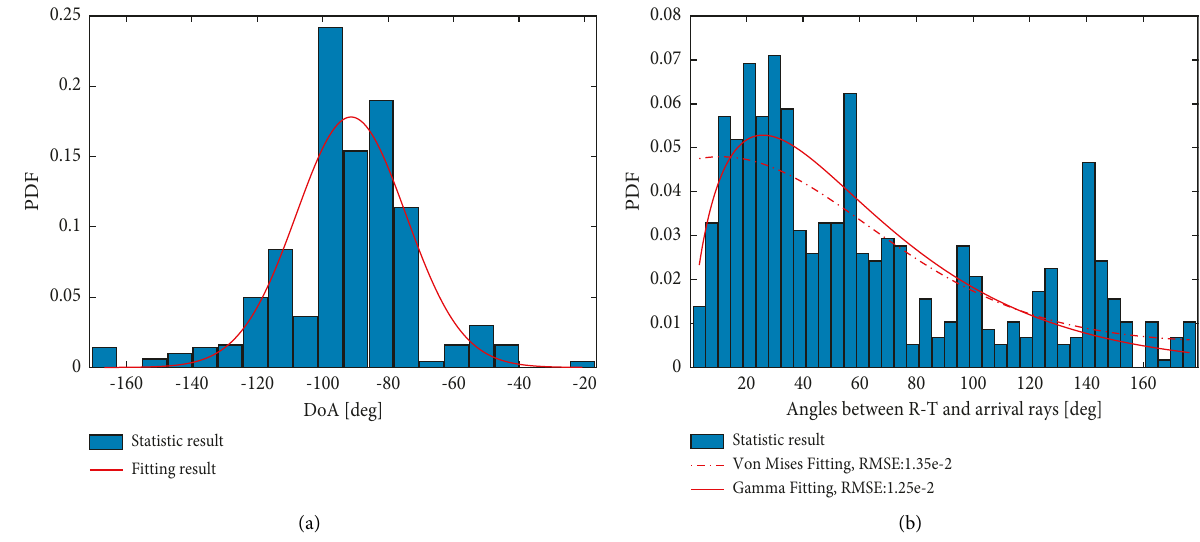
Figure 5: Comparisons of two angular statistics, (a) AoAs and (b)